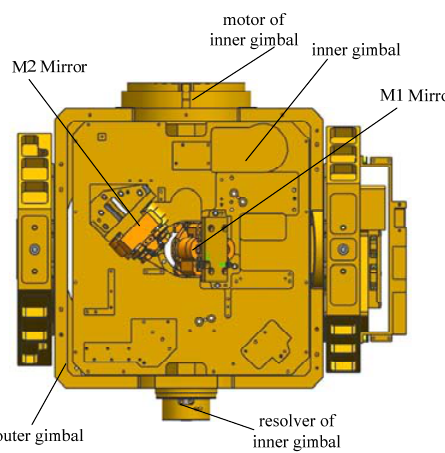
Figure 1. Diagram of compensating mirror and gimbal.